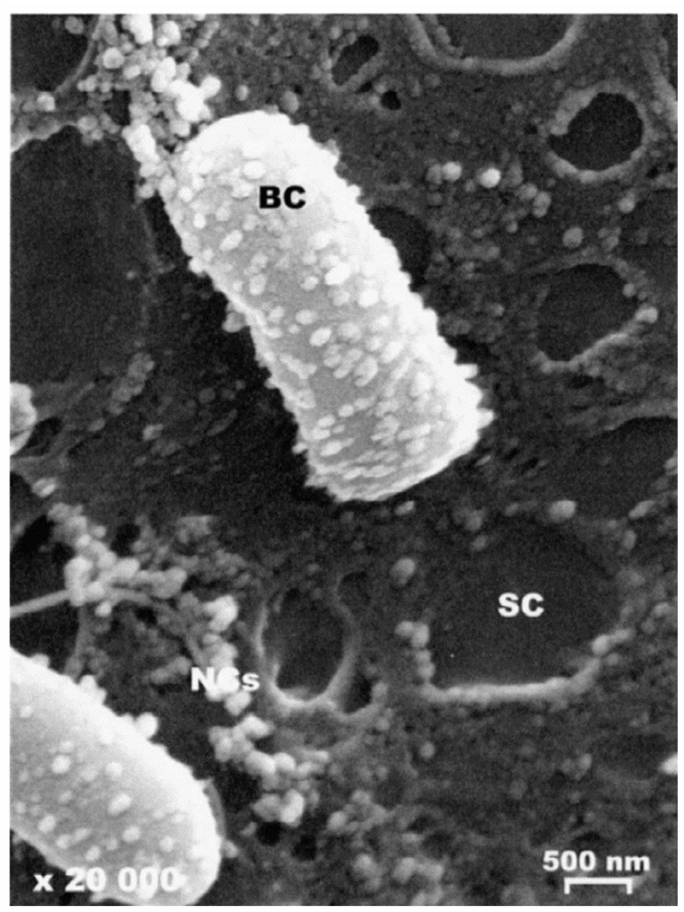
Figure 8. Scanning electron micrographs of 0.6% chlorhexidine base loaded PCL nanocapsules localization on stratum corneum-associated bacteria. Drug loaded nanocapsules adsorbed on bacteria membrane (BC). Reproduced with permission from [110], Journal of Controlled Release,